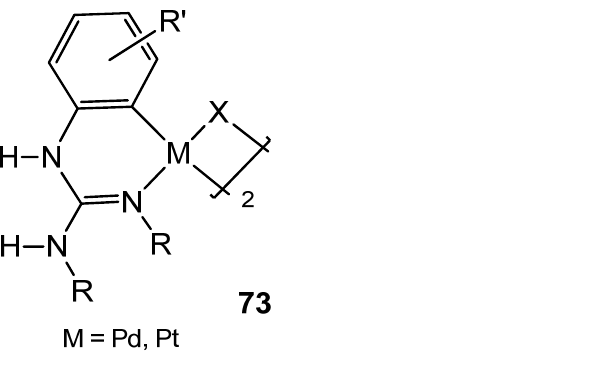
Figure 45. Cyclometalated guanidinato palladium and platinum complexes.